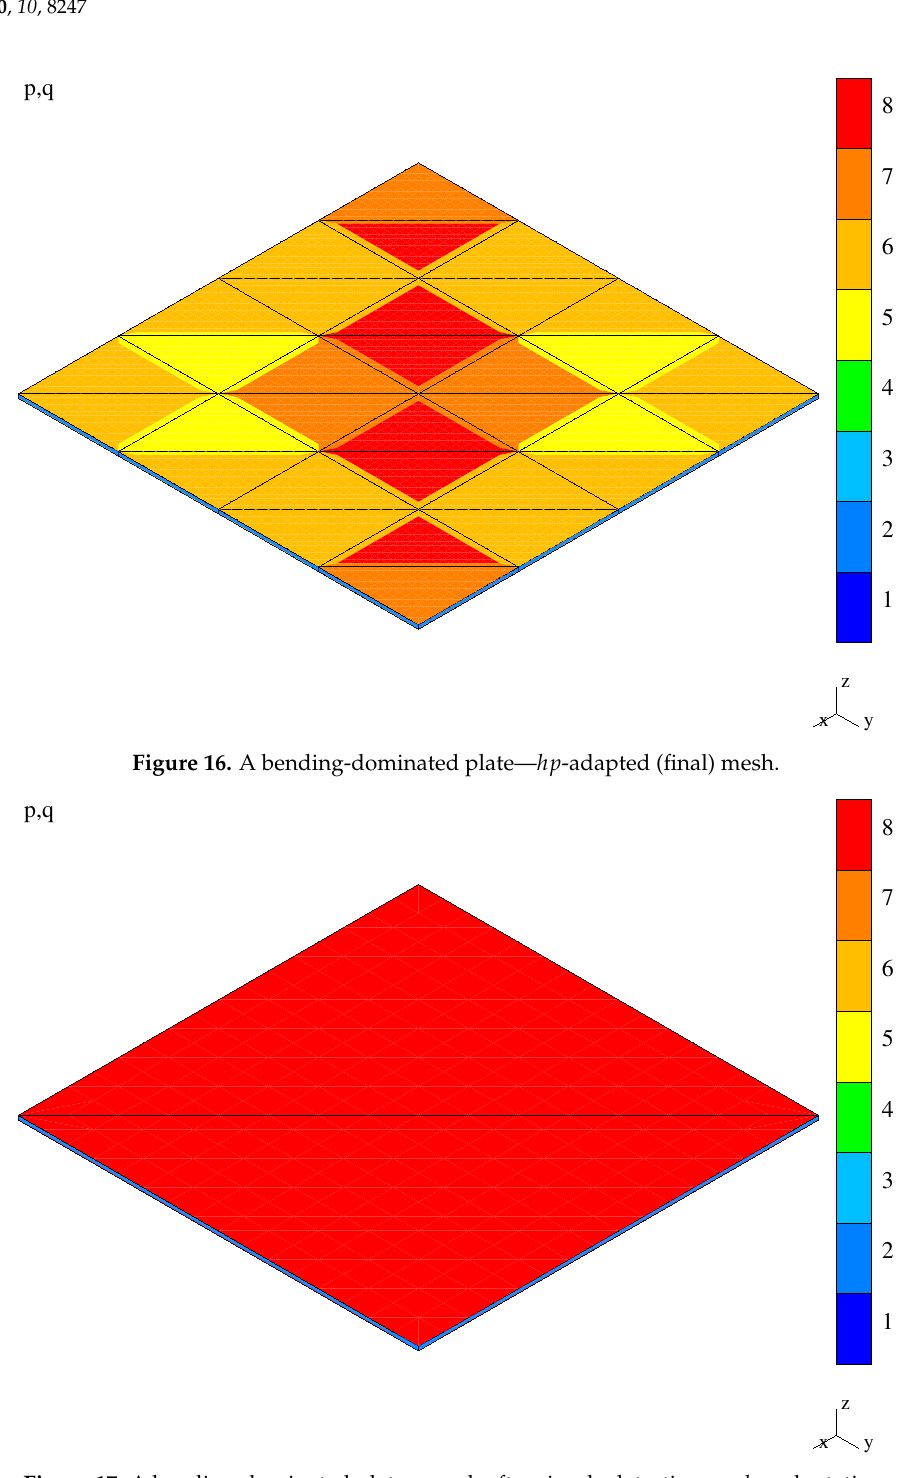
Figure 17. A bending-dominated plate—mesh after simple detection, no hp